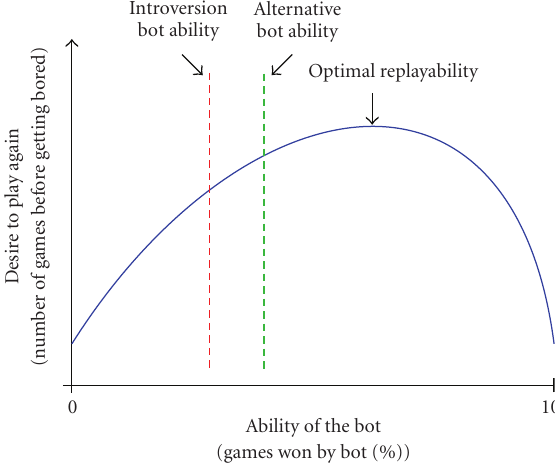
Figure 10: Graph for enjoyability as a function of bot ability